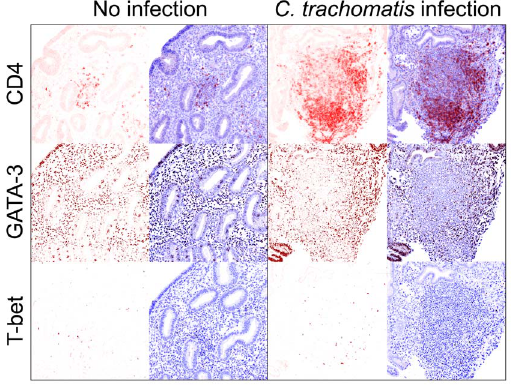
Figure 4. Endometrial Chlamydia infection is associated with the presence of CD4 + T cell aggregates and high expression of the T H 2 transcription factor GATA-3. Sequential sections of paraffin-embedded endometria from women with no identified C. trachomatis , N. gonorrhoeae , or T. vaginalis lower or upper genital tract infection (n=4) or with endometrial C. trachomatis infection (n=6) were used to immunohistochemically evaluate T-bet or GATA-3 expression (both DAB), and the presence of CD4 + mononuclear cells (Vector Red) as described in Methods section. Aggregates of GATA-3 + (but not T-bet + ) and CD4 + mononuclear cells were seen in endometrial stroma of Chlamydia -infected tissue (representative micrographs shown at X200 magnification). Moreover, only a few CD4 + mononuclear cells were present in uninfected endometrial tissue even tough GATA-3 was expressed at high levels in both instances. Right panels show images displaying DAB or Vector Red staining and hematoxylin as counterstain, while left panels show DAB or Vector Red layer alone.